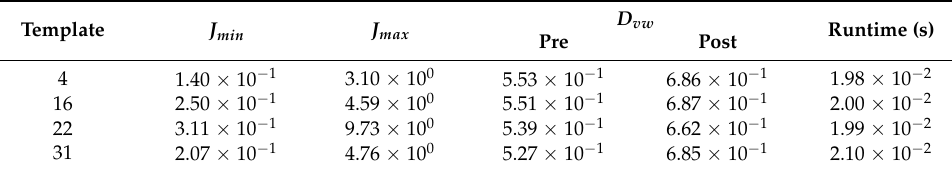
Table 4. Experiment 1: Performance of ANTs . We report results for registration of four template im- ages to the reference image Template27 using a squared L 2 -distance metric. We report the following quantities of interest (i) minimum ( J min ) and maximum ( J max ) determinant of the deformation gradi- ent obtained, (ii) label volume weighted Dice average D vw pre and post registration, and (iii) solver wall clock time in seconds.